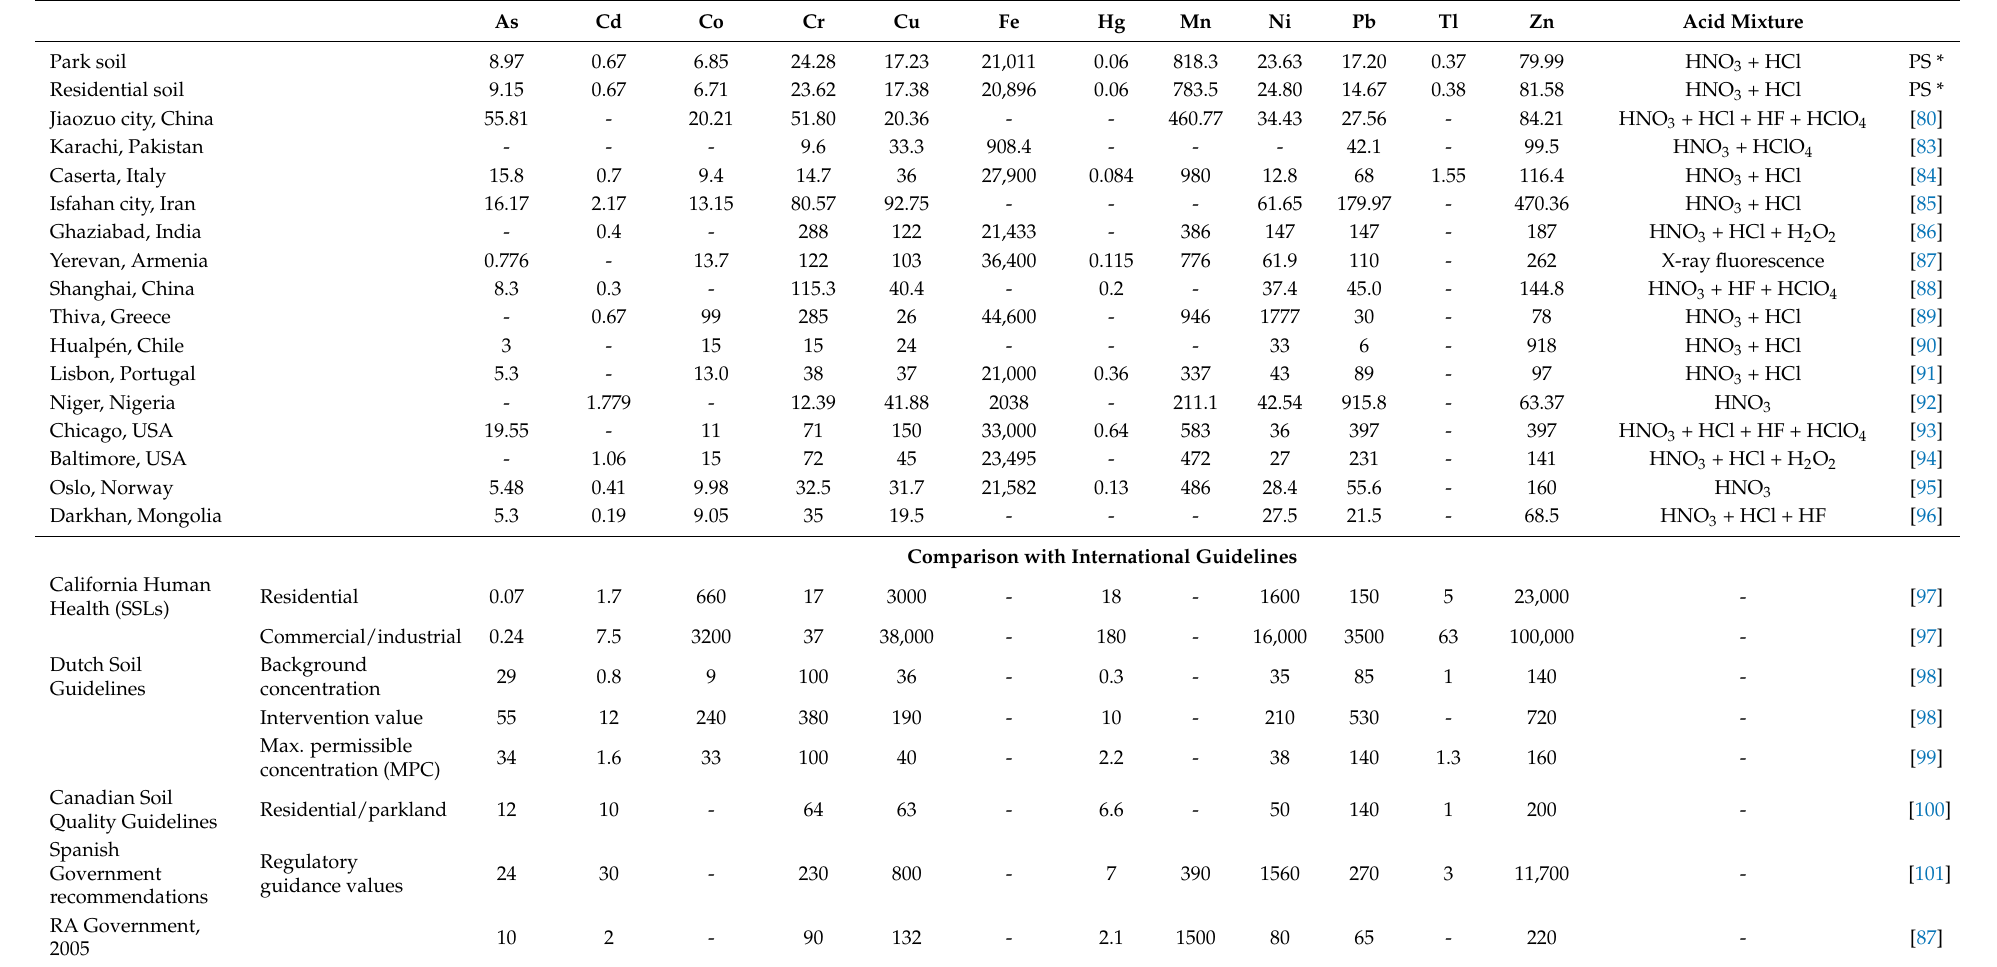
Table 2. Average metal concentrations ( µ g/g, dry weight) in soil in comparison with the worldwide reported levels and the international guideline